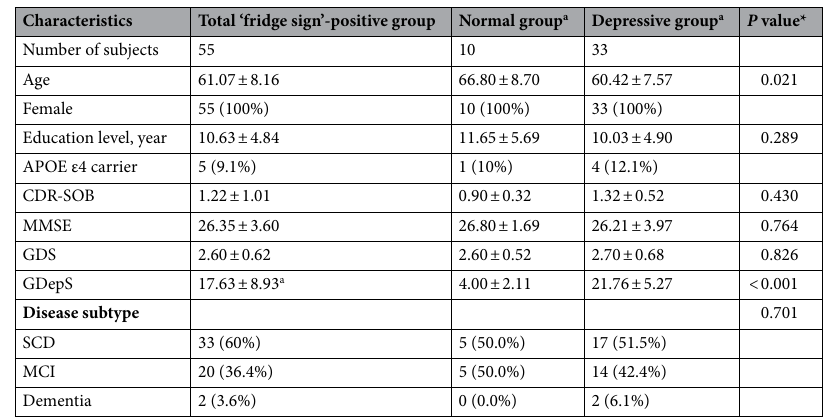
Table 1. Demographic findings of ‘fridge sign’-positive patients and the comparison between depressive and normal groups according to the Geriatric Depression Scale score. Values are given as the mean ± standard deviation or number (%). CDR Clinical Dementia Rating, CDR-SOB Clinical Dementia Rating—Sum of box, MMSE Mini-Mental Status Examination, GDS Global Deterioration Scale, GDepS Geriatric Depression Scale, SCD subjective cognitive decline, MCI mild cognitive impairment. * P values were obtained using the Mann– Whitney test or Pearson’s chi-squared test between the normal and depressive groups as appropriate. a Only 43 subjects with detailed neuropsychological test scores, including Geriatric Depression Scale scores, were included in the normal and depressive